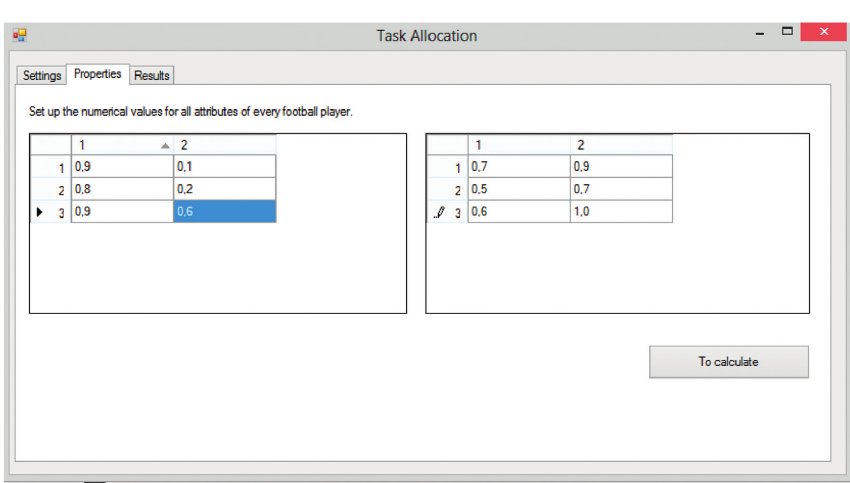
Figure 4: Entering the numerical characteristics of the properties for each robot.